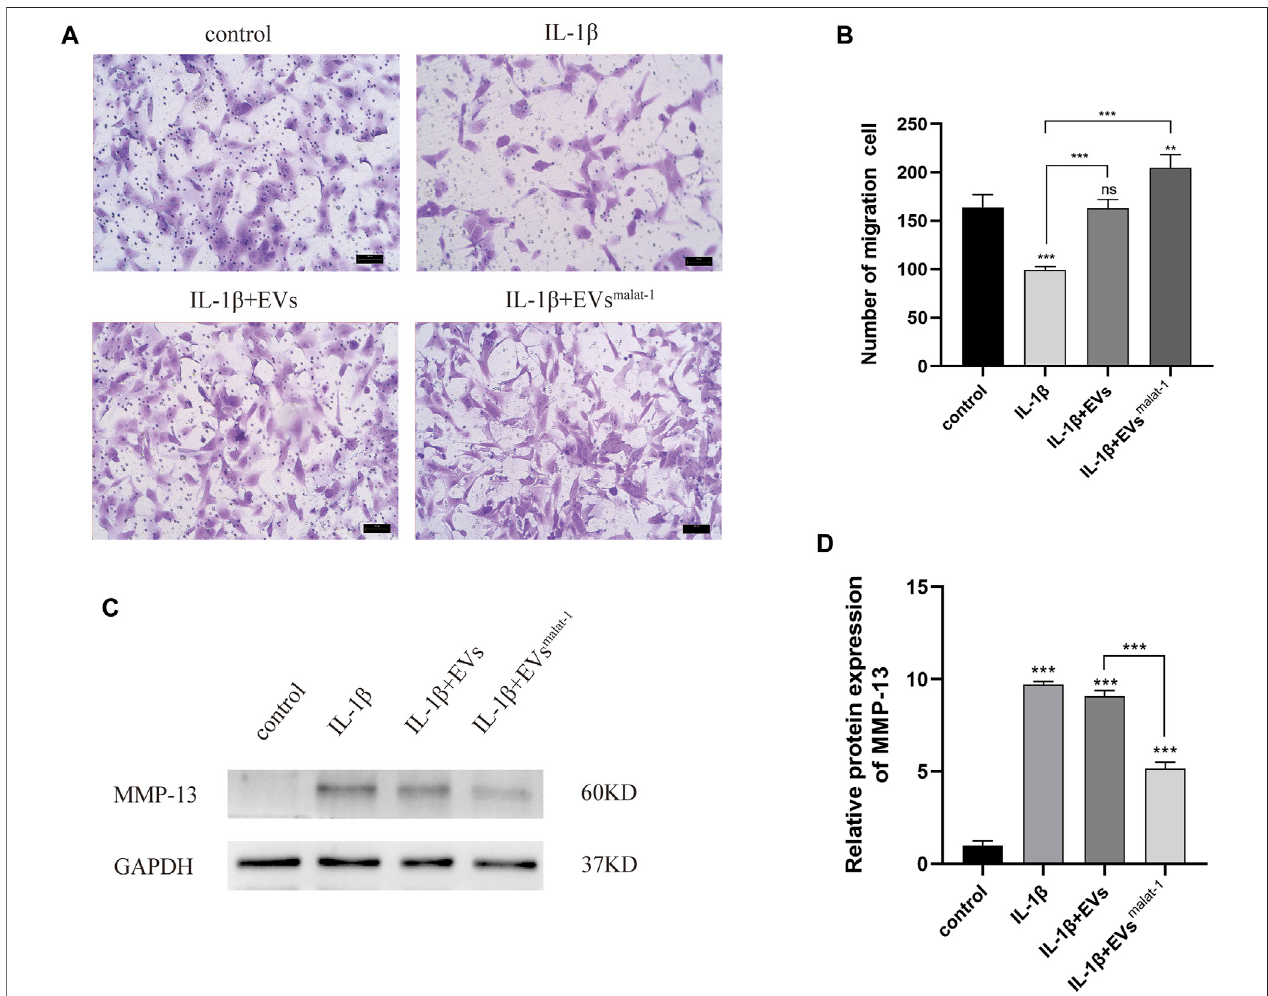
FIGURE5|(A) and (B) MigrationofchondrocyteswasdetectedbyTranswellassays.** p < 0.01,*** p < 0.001vs.IL-1 β group. (C) and (D) Theproteinexpressionof MMP-13 was detected by western blot, * p < 0.05, ** p < 0.01, *** p < 0.001, vs. control group. n (cid:2) 3, one-way ANOVA for